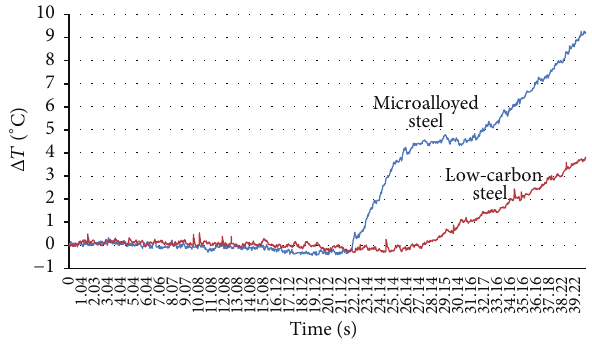
Figure 4: Change in maximum temperatures during the elastic and at the beginning of plastic deformation of low-carbon and niobium microalloyed